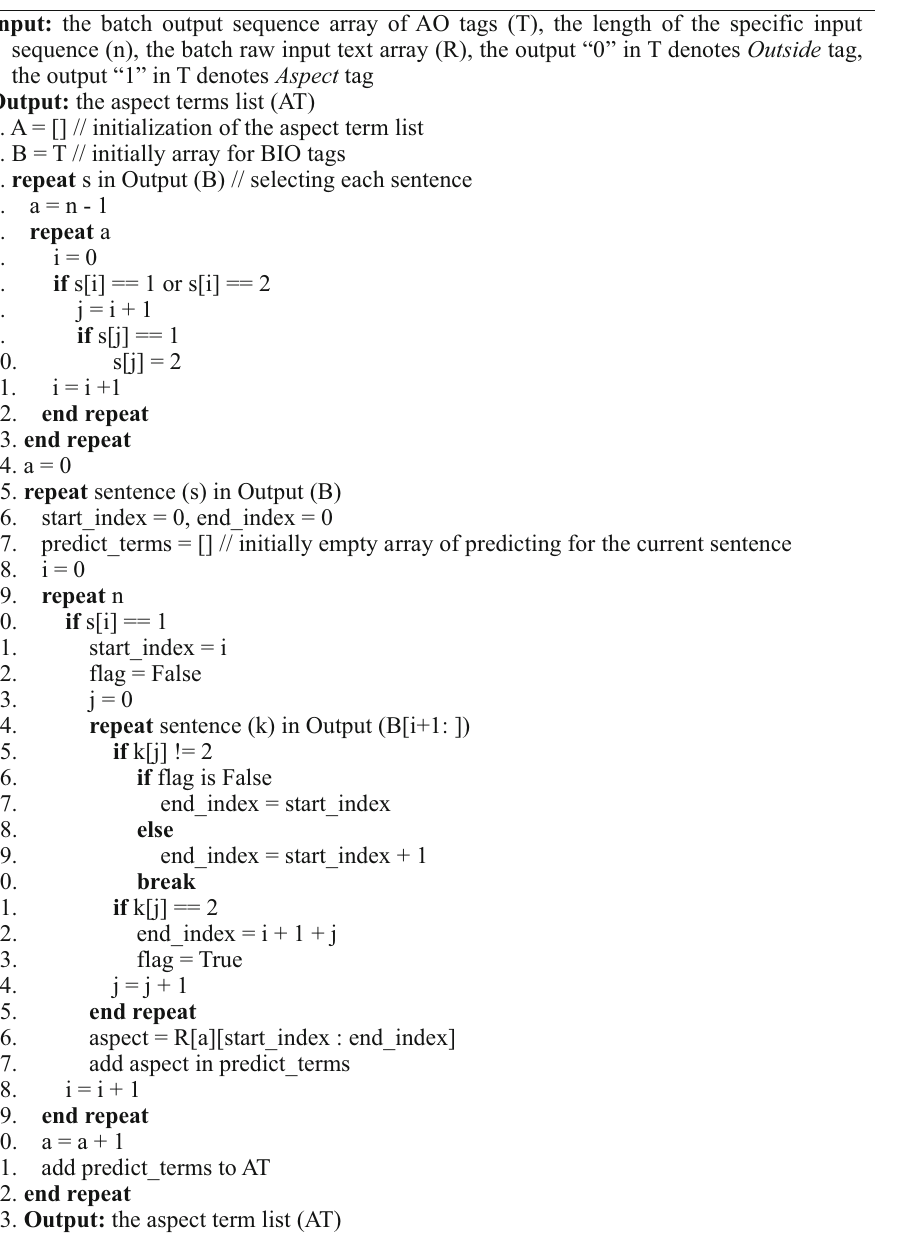
Algorithm 1 The process of extracting different aspect terms under AO